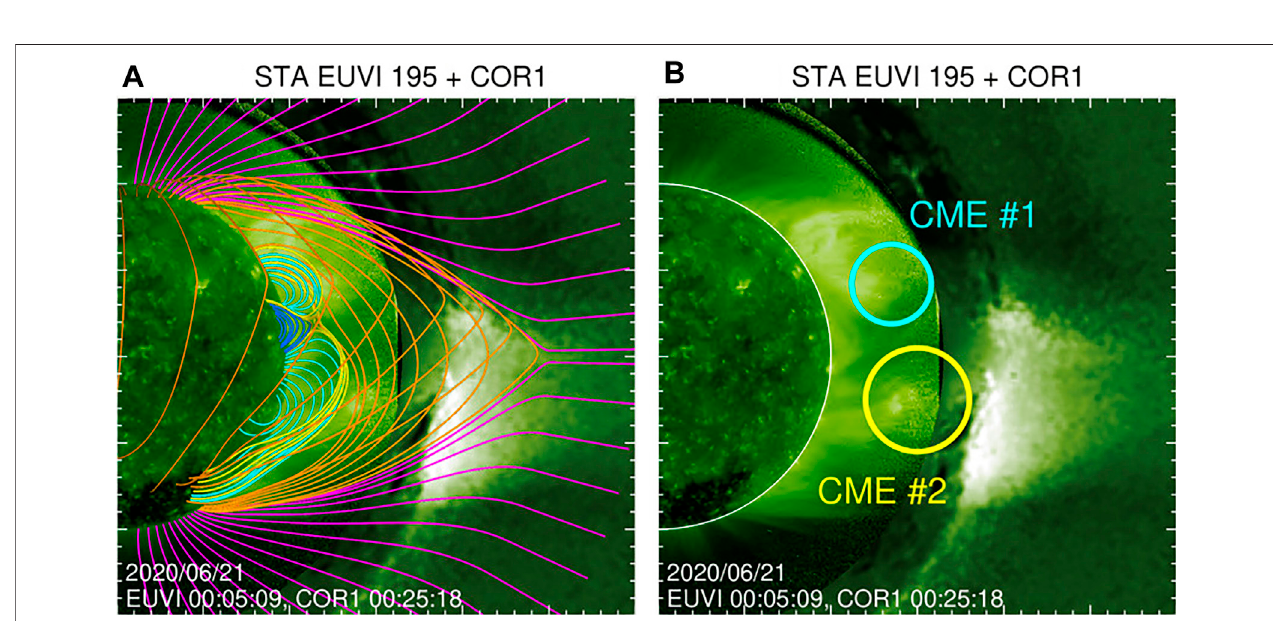
FIGURE 3 | (A) Composite image showing the limb-enhanced STA/EUVI 195Å emission together with the processed STA/COR1 white light observations. Representative PFSS magnetic fi eld lines are also shown to identify the (approximate) positions of the different fl ux systems on the west limb. (B) The same composite imageaspanel (A) withannotationtoshowthepre-eruption( fl uxrope)progenitorsforCME#1(cyan)andCME#2(yellow)at r ~1.3 R ⊙ inthenorthernandsouthernside- lobe arcades, respectively. An animation of the limb-enhanced STA/EUVI data is included as Supplementary Video S1 in the supplementary materials.